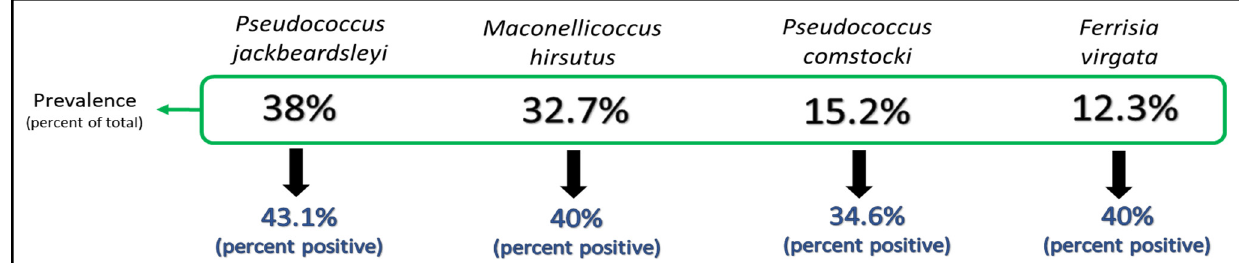
Figure 3. Mealybug species collected from virus-infected cacao trees, listed (left to right) in decreasing order of relative abundance (prevalence). Cacao mild mosaic virus sequences were obtained from 34.6 to 43.1% of insects collected.